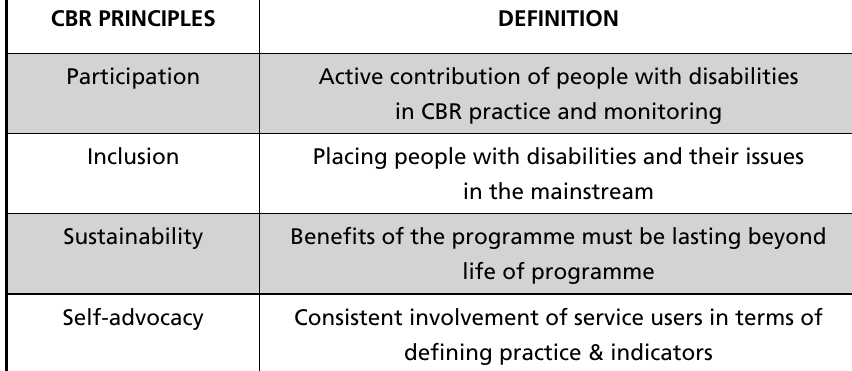
table 3: Principles of cbR (WhO 2010)